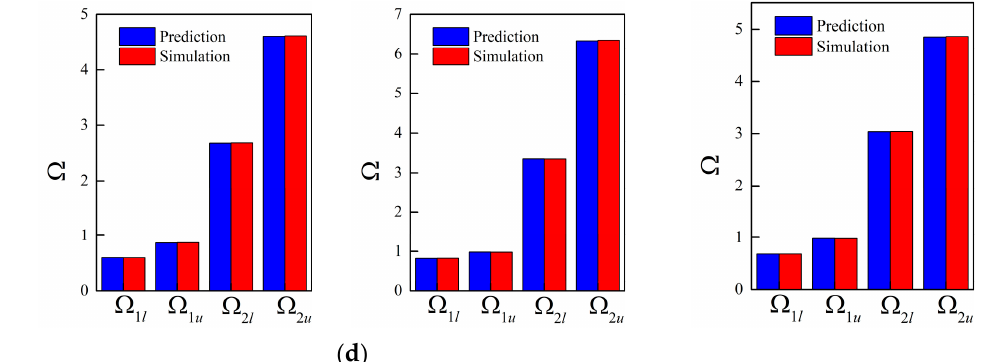
Figure 4. Correlation between the bounding frequencies obtained by the NN and TMM models for the forward design of micro-PnC beams ( a ) incorporating size effects and ( b ) without size effects; ( c ) random examples of band gap characteristics predicted by NNs considering the length scale parameter and ( d ) NNs excluding the length scale parameter. The red column denotes the ground truth of band gaps. Table 3. Random designs of material properties for the micro-PnC beam.